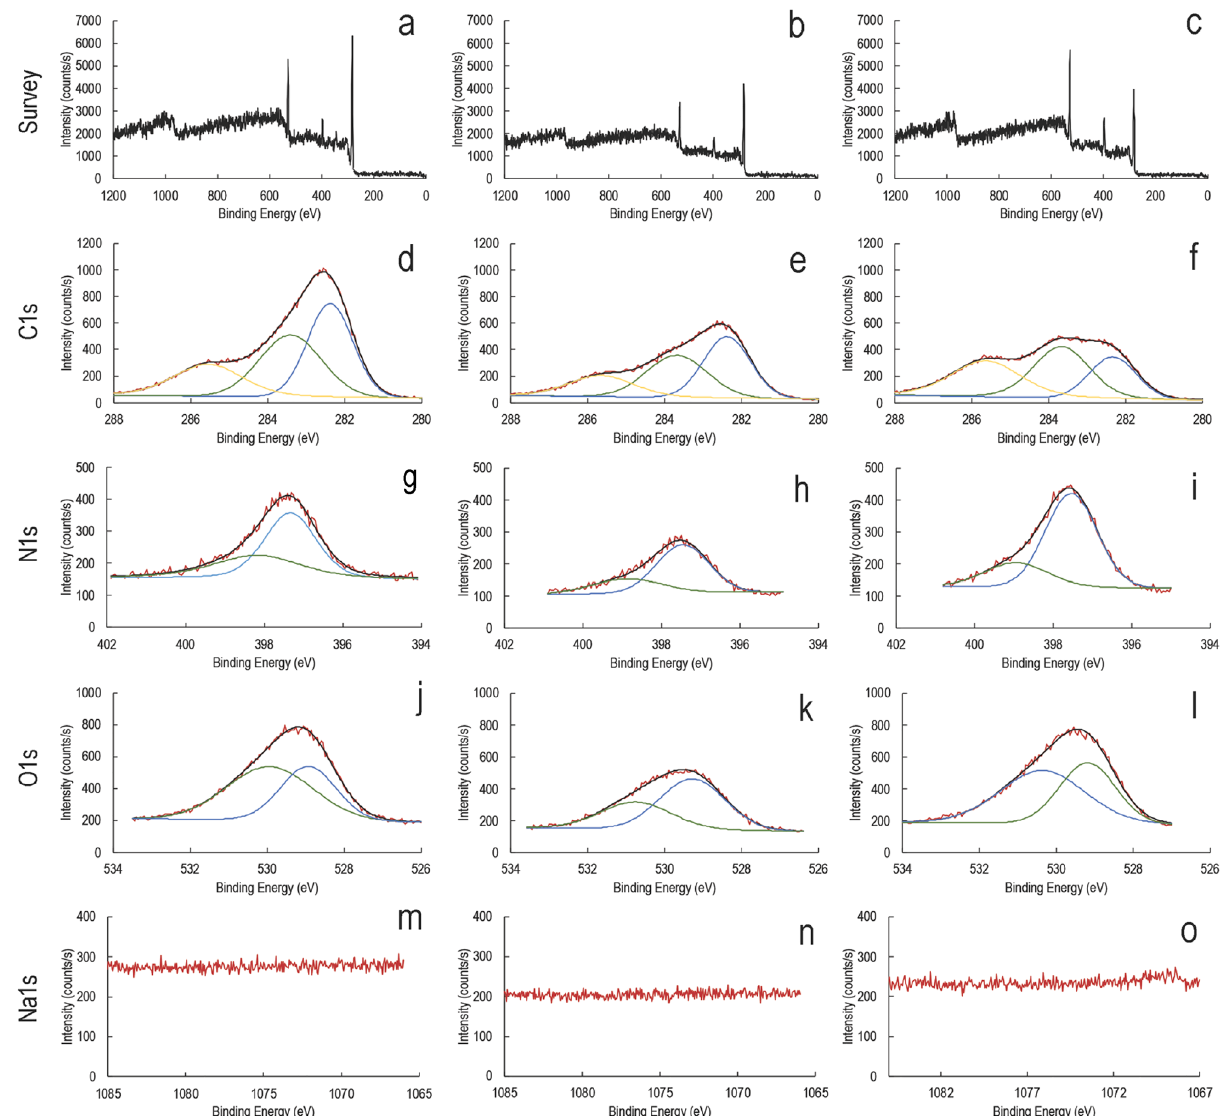
Figure 5. Representative XPS spectrum for dry silk cocoon, silk cocoon soaked in water, silk cocoon soaked in water and exposed to water vapor. Survey spectrum of the dry silk cocoon. Blue, green, and yellow color XPS peaks code lowest to the highest binding energy. The corresponding binding energy values with respective color coding are available in Table 1 ( a ), silk cocoon soaked in water ( b ), silk cocoon soaked in water, and exposed to water vapor ( c ). Comparative C1s spectrum for the dry silk cocoon ( d ), silk cocoon soaked in water ( e ), silk cocoon soaked in water, and exposed to water vapor ( f ). Comparative N1s spectrum for the dry silk cocoon ( g ), silk cocoon soaked in water ( h ), silk cocoon soaked in water, and exposed to water vapor ( i ). Comparative O1s spectrum for the dry silk cocoon ( j ), silk cocoon soaked in water ( k ), silk cocoon soaked in water, and exposed to water vapor ( l ). Comparative Na spectra for the dry silk cocoon ( m ), silk cocoon soaked in water ( n ), silk cocoon soaked in water, and exposed to water vapor ( o upon exposure to water vapor (Fig. 5c). Upon further exploring the narrow spectrum for C1s, in Figs. 5d–f, we observed that the presence of low bond energy species of carbon on the surface reduces upon wetting and further upon exposure to water vapor. Nitrogen and oxygen narrow-spectrum show a similar trend of reduc- ing surface species and their recovery upon exposure to water vapor (Fig. 5g–l). So, as shown in the table, the C:N:O surface composition in dry form is 4:1:2.5. In wet form 2.64:0.55:1.71 and upon water vapor exposure is 3.0:0.99:2.57. The changing C:N:O ratio is evidence of membrane reorganization, where wetting leads to soften- ing of the originally rigid membrane. Exposure to energy-rich water vapor fuels the alignment of electron-rich species like C–N, C=O, and OCNH2 species that act as molecular wires to conduct charge. So, this biologi- cal membrane is a programmable matter exhibiting its transformation from poorly conducting to conducting matrix upon interaction with energy-rich water molecules. Figure 5m–o showed the baseline spectra of Na1s.